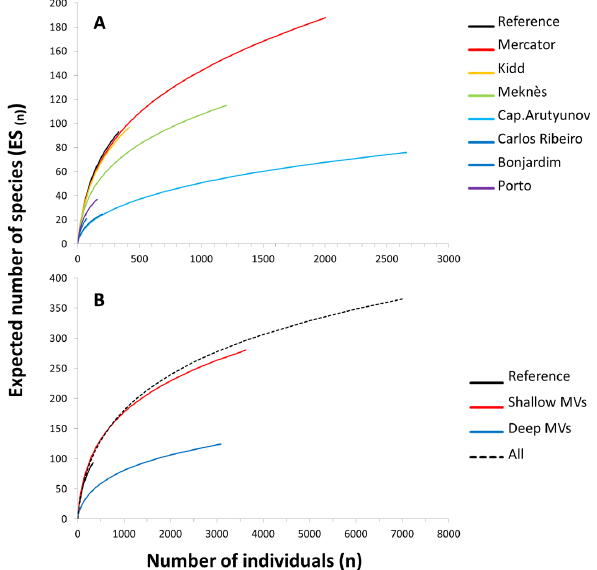
Fig. 5. Comparison of rarefaction curves (Hurlbert’s expected num- ber of species) for the assemblages pooled by mud volcano (A) and pooled by sub-region (B) .